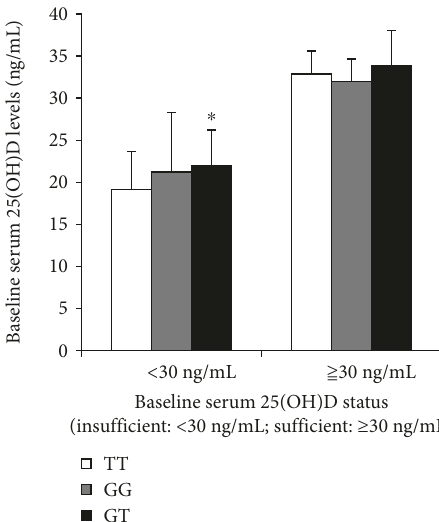
Figure 2: The levels of serum 25(OH)D in patients with di ff erent CYP27B1 (10877012) genotypes before vitamin D White bars: CYP27B1 rs10877012 TT genotype; gray bars: CYP27B1 rs10877012 GG genotype; black bars: CYP27B1 rs10877012 GT genotype. All data were expressed as means ± SD . ∗ P < 0 05 .